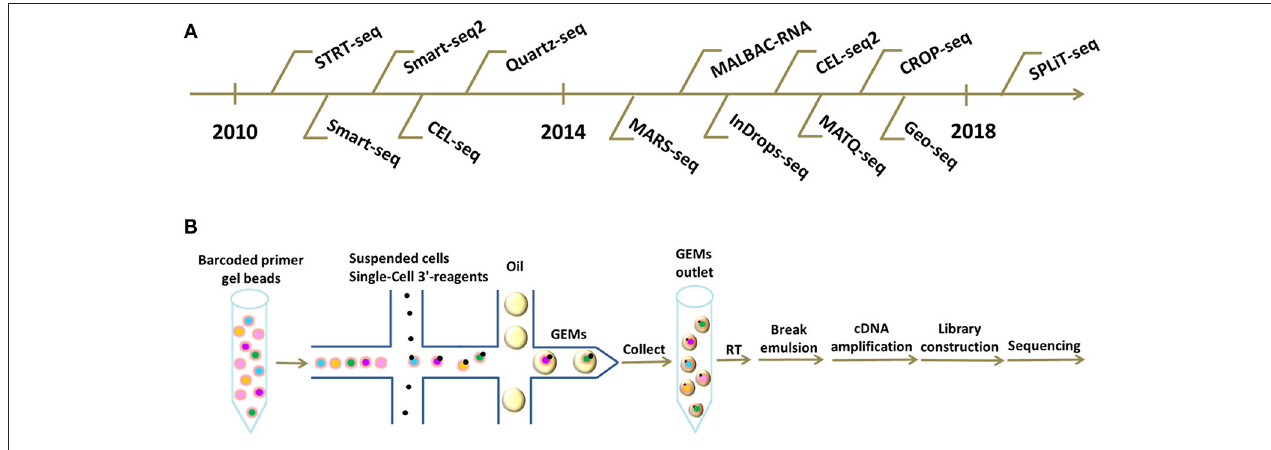
FIGURE 1 | Different scRNA-seq technologies and frontier cDNA library construction platforms. (A) Chronological chart of existing scRNA-seq technologies. (B) Workflow of scRNA-seq based on 10X Genomics platform. Briefly, suspended cells and Single-Cell 3’-reagents are added into the microfluidics chip. Subsequently, together with barcoded primer gel beads and oil-surfactant solution, GEMs are formed in a “double cross” way. Single GEMs are collected in the GEMs outlet. Next, reverse transcription is initiated inside each GEM. Afterwards, GEMs are broken and barcoded cDNAs are pooled for amplification and library